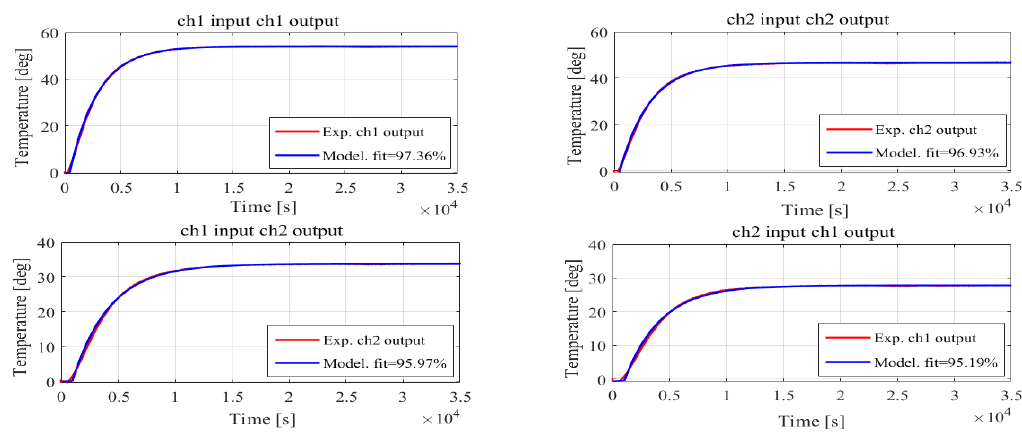
Figure 7. System identification